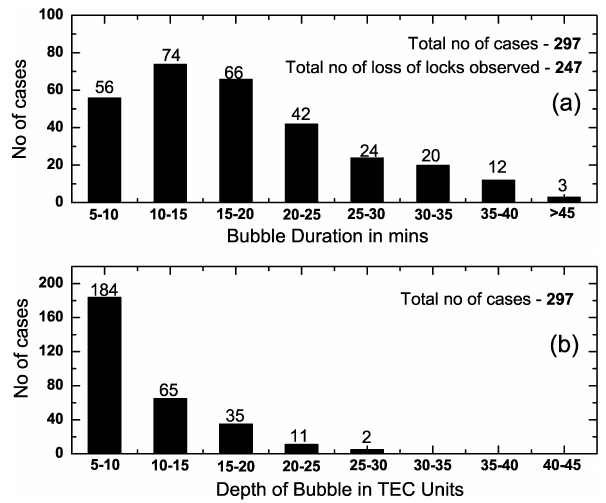
Fig. 7. Histograms showing the duration (a) and intensity (b) of the TEC depletions observed over the Indian region for the month of March